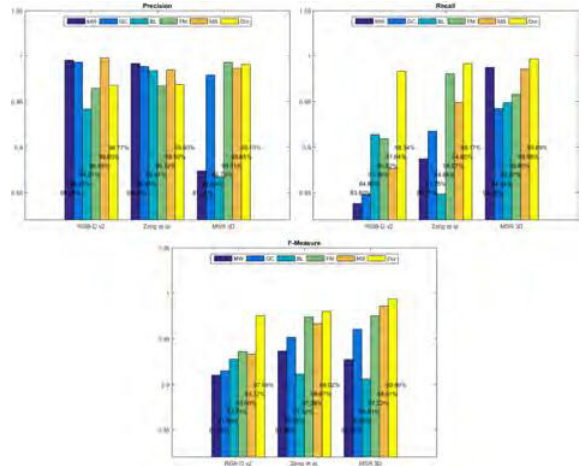
Quantitative analysis of different methods. MW: magic wand, GC: grab-cut [6], BL: graph-based on color information only (i.e., baseline method), FM: the fast mode of Ref. [5] with depth layer, MS: mean-shift color-depth with depth layer, Our: our approach. The horizontal axis represents different